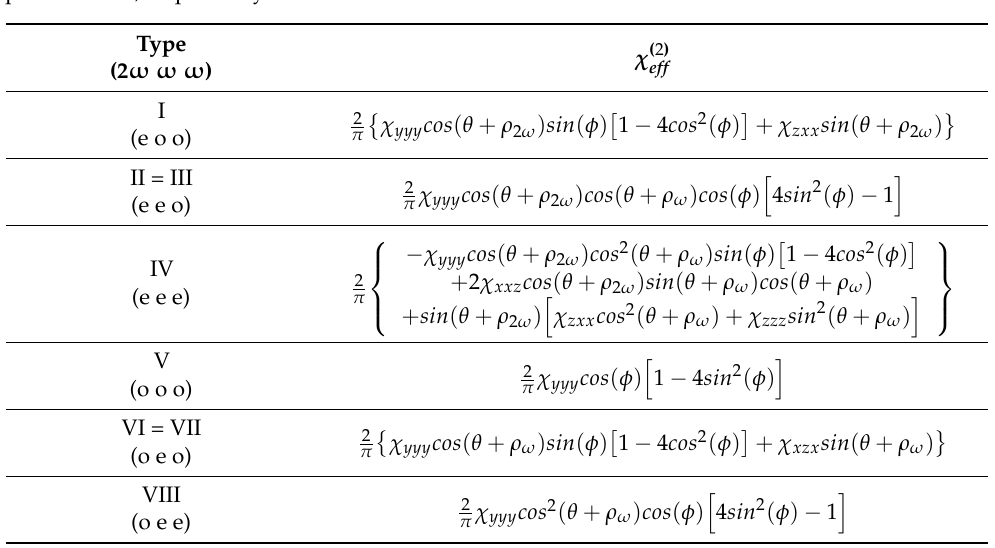
Table 1. Effective coefficients of AQPM SHG corresponding to all possible configurations of po- larization for AQPM SHG for the crystal class 3m and the negative uniaxial optical class, which is the case of 5%MgO:PPLN. The χ ijk ’s stand for the independent coefficients of the second-order electric susceptibility tensor at 2 ω . ρ ω and ρ 2 ω are the double refraction angles of the fundamental and second-harmonic waves, respectively. (o) and (e) stand for the ordinary and extraordinary polarizations, respectively.